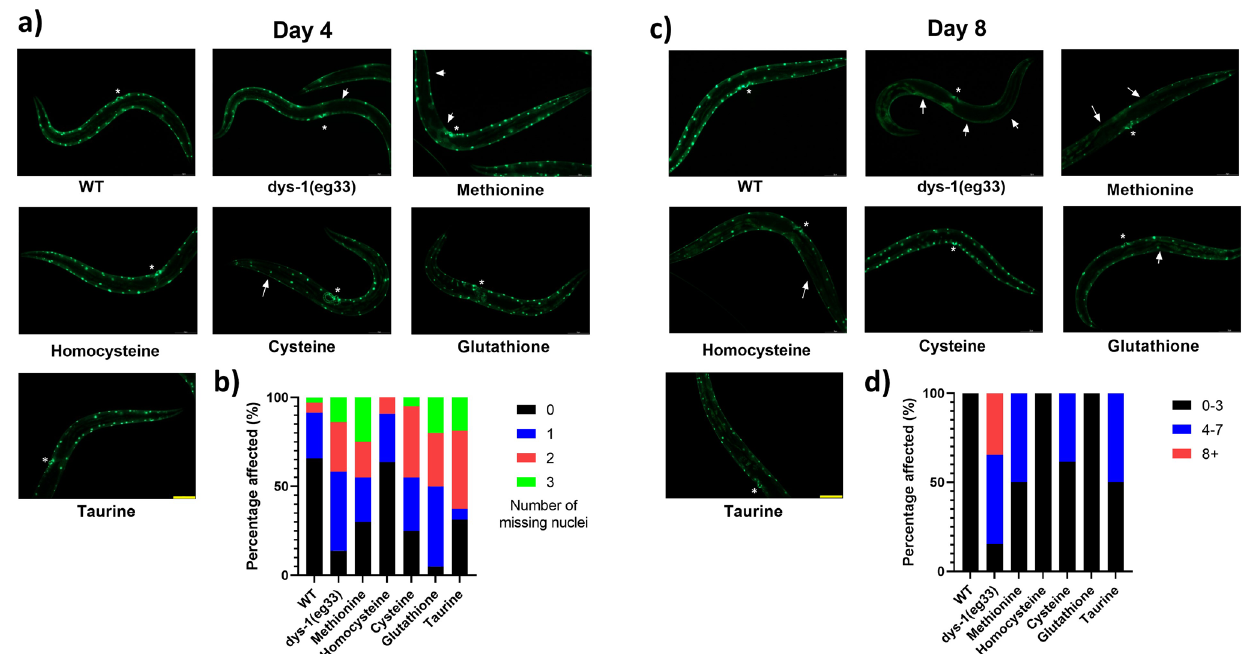
Fig. 3 SAA mildly delay onset of cell death at Day 4 post-adulthood, with signi fi cant preservation at Day 8. a Representative images of muscle cell death in CB5600 ( wt ), CC91 ( dys-1(eg33) ) and CC91 treated with SAA: L-Methionine (10 mM), L-homocysteine (10 µ M), L-cysteine (10 µ M), L-glutathione (100 µ M) and L-taurine (10 µ M). Muscle cell death (as identi fi ed by the absence of muscle nuclei) was more pronounced in the dys-1(eg33) animals compared to wt . b The scatter bar graph shows a higher proportion of animals with no missing nuclei when treated with SAA bar L-glutathione. However, the proportion of animals with 2 or more missing nuclei was similar across all groups bar L-homocysteine. c Representative images of muscle cell death in CB5600 ( wt ), CC91 ( dys-1(eg33) ) and CC91 treated with SAA: L-Methionine (10 mM), L-homocysteine (10 µ M), L-cysteine (10 µ M), L-glutathione (100 µ M) and L-taurine (10 µ M). Muscle cell death was more pronounced in the dys-1(eg33) animals compared to wt at Day 8 post-adulthood. d The scatter bar graph shows a higher proportion of animals with 0 – 3 missing nuclei when treated SAA in particular, L-homocysteine and L-glutathione. Vulva is identi fi ed by the * and arrows show the missing nuclei. Scale bar: 30 µ m. Data are means from 20 animals across two biological repeats.